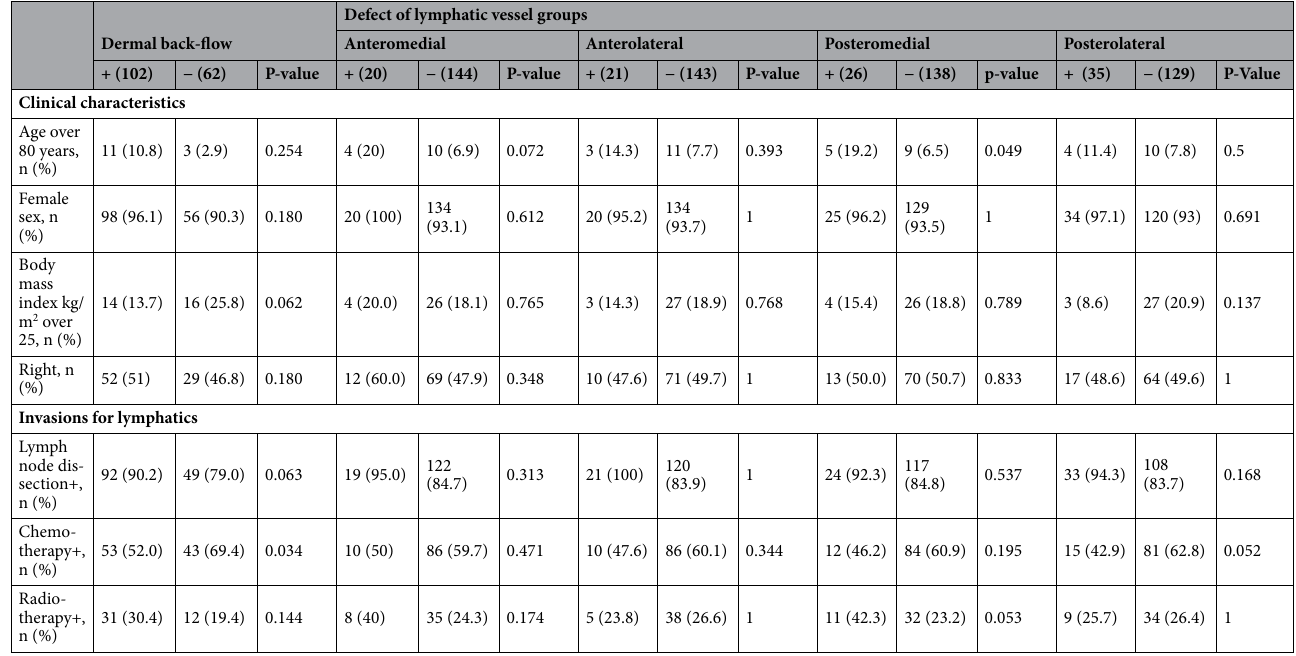
Table 3. Baseline characteristic for logistic regression analysis.